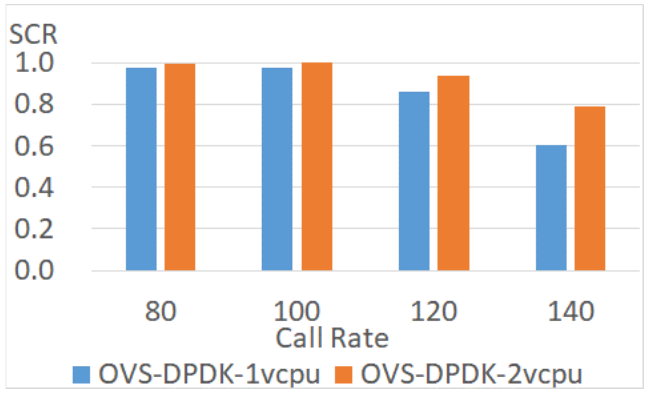
Figure 20. Successful call rate of vIMS with different VM sizes using